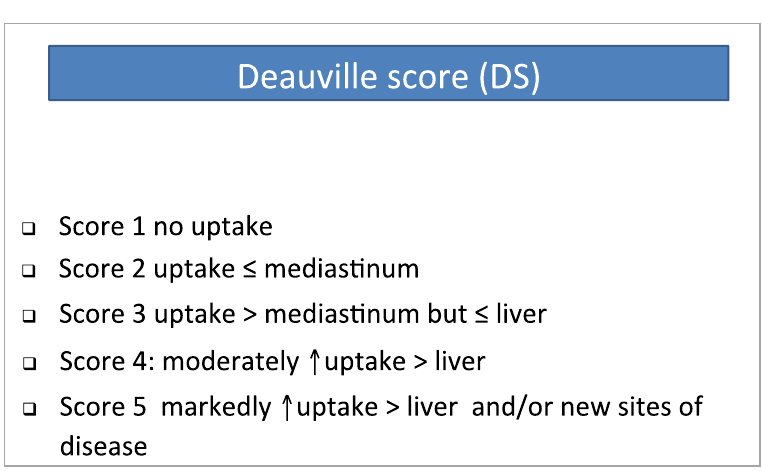
Figure 1. Deauville score